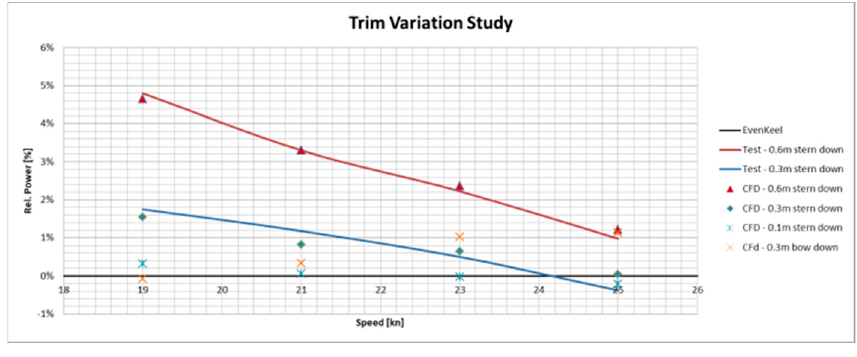
Figure 16. Results of trim variation studies from model tests and CFD .